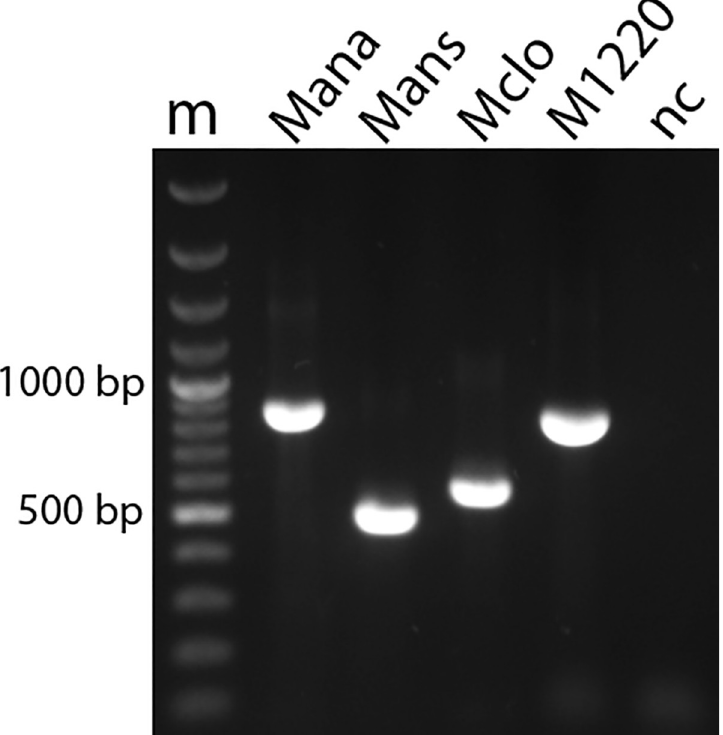
Fig 1. Sizes of the PCR amplicons of Mycoplasma species generated by the species-specific PCR assays. Abbreviations: m—molecular weight marker (GeneRuler 100 bp Plus DNA Ladder, Thermo Fisher Scientific, Waltham, USA); Mana—product from the M . anatis -specific assay; Mans—product from the M . anseris -specific assay; Mclo—product from the M . cloacale -specific assay; M1220—product from the M . sp. 1220-specific assay; nc—negative